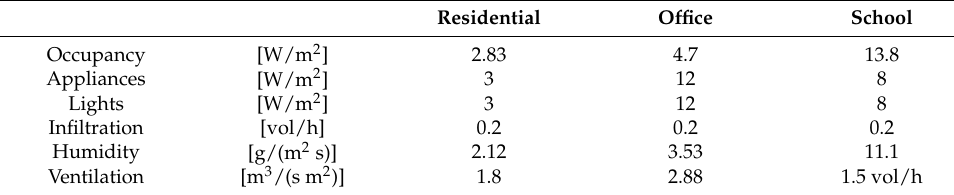
Table 2. Assumptions for the internal heat gains, ventilation and infiltration